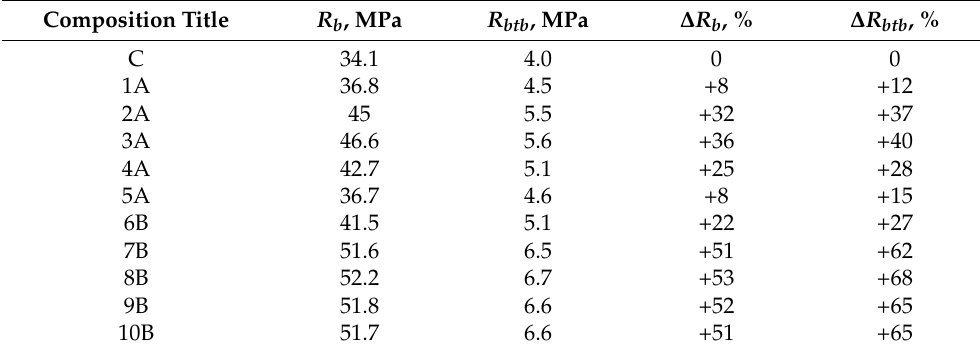
Table 10. Increases in strength characteristics of fine-grained geopolymer concrete depending on the dosage of micro calcite and potassium